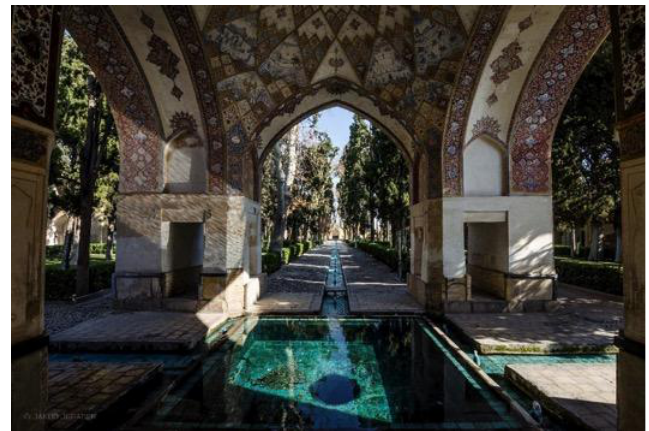
Figure 11. The art of symmetry in all component of Fin Garden with view to four directions. Kashan. Photo